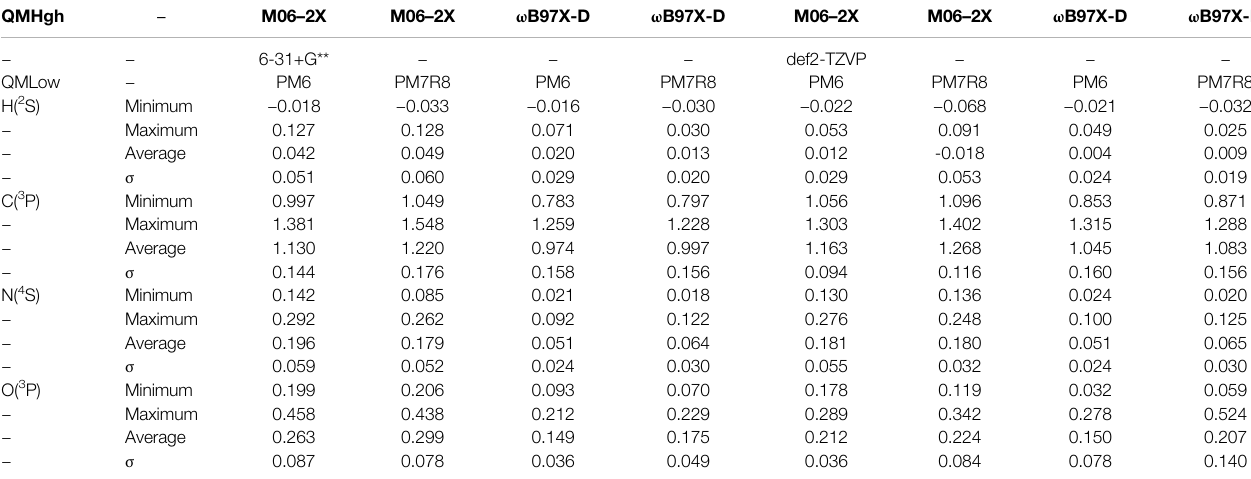
TABLE 1 | Calculated BE ’ s at ONIOM level for atomic